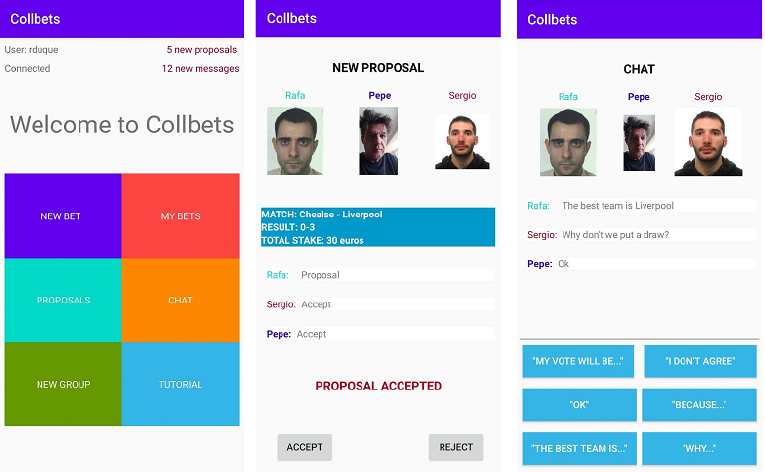
Figure 5. Main user interface of the system ( left panel ), voting panel ( center panel ), and structured chat ( right panel